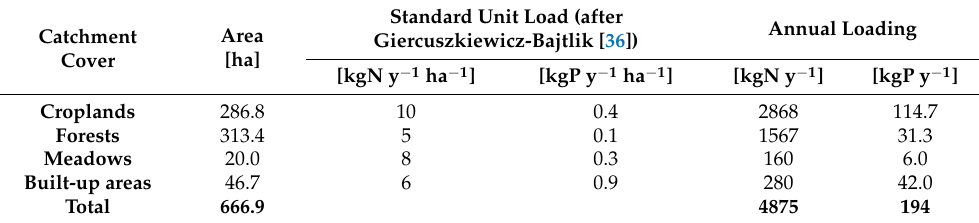
Table 7. Nitrogen and phosphorus loads from the direct catchment of the lake.